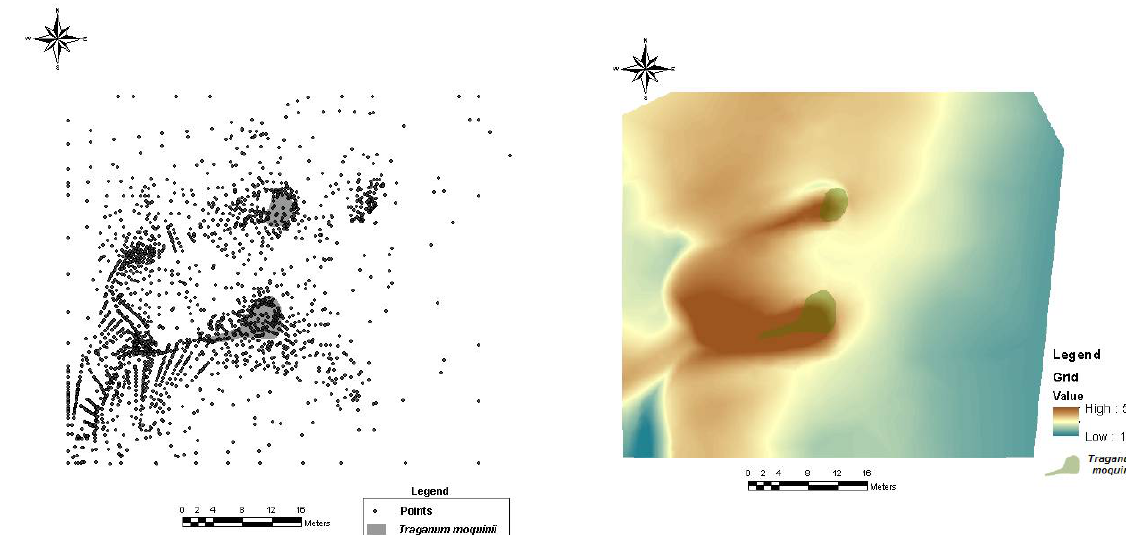
Figure 10. Experimental plot topographic survey and DEM.